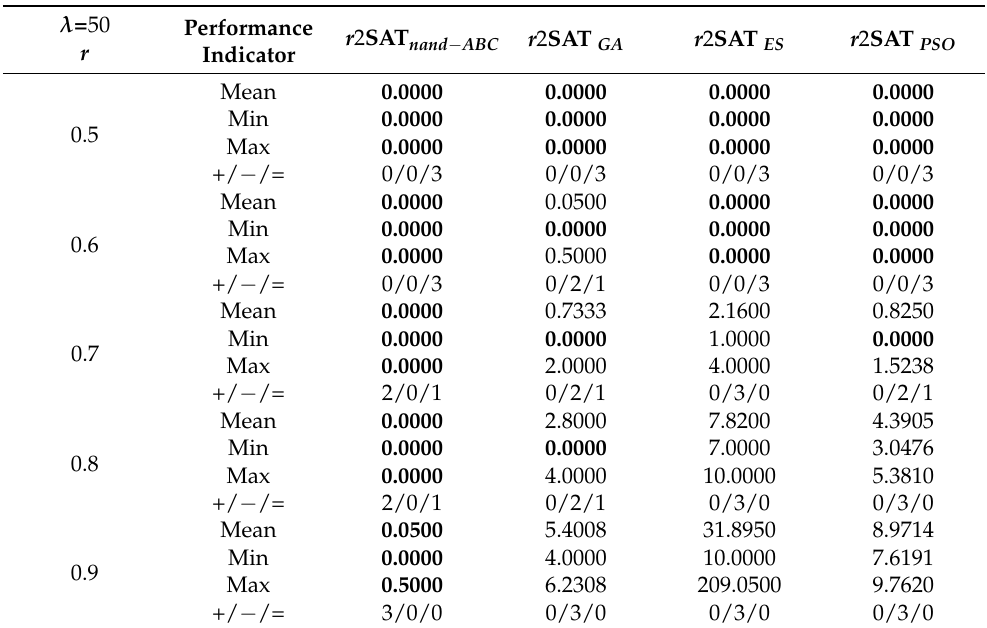
Table 17. Comparison of r 2SAT nand − ABC against other binary algorithms in terms of MAE for λ =